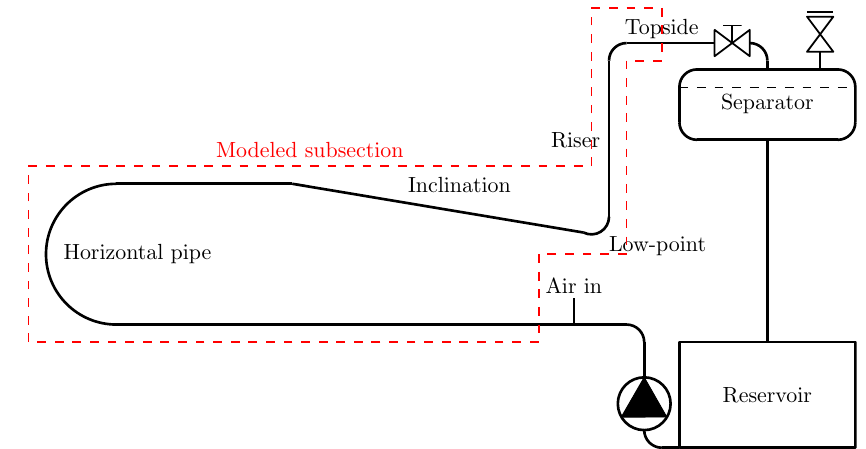
Figure 2. Overview of test